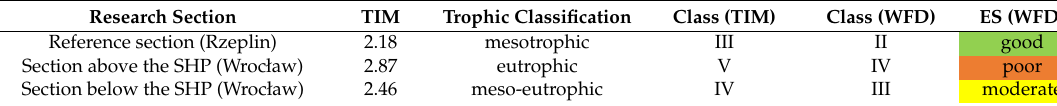
Table 15. ES (macrophytes) as identified by TIM.